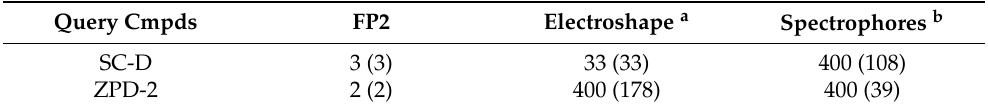
Table 1. Number of hits obtained from the VS runs employing SC-D and ZPD-2 as query molecules. The number of compounds selected from each approach for further analysis is reported in